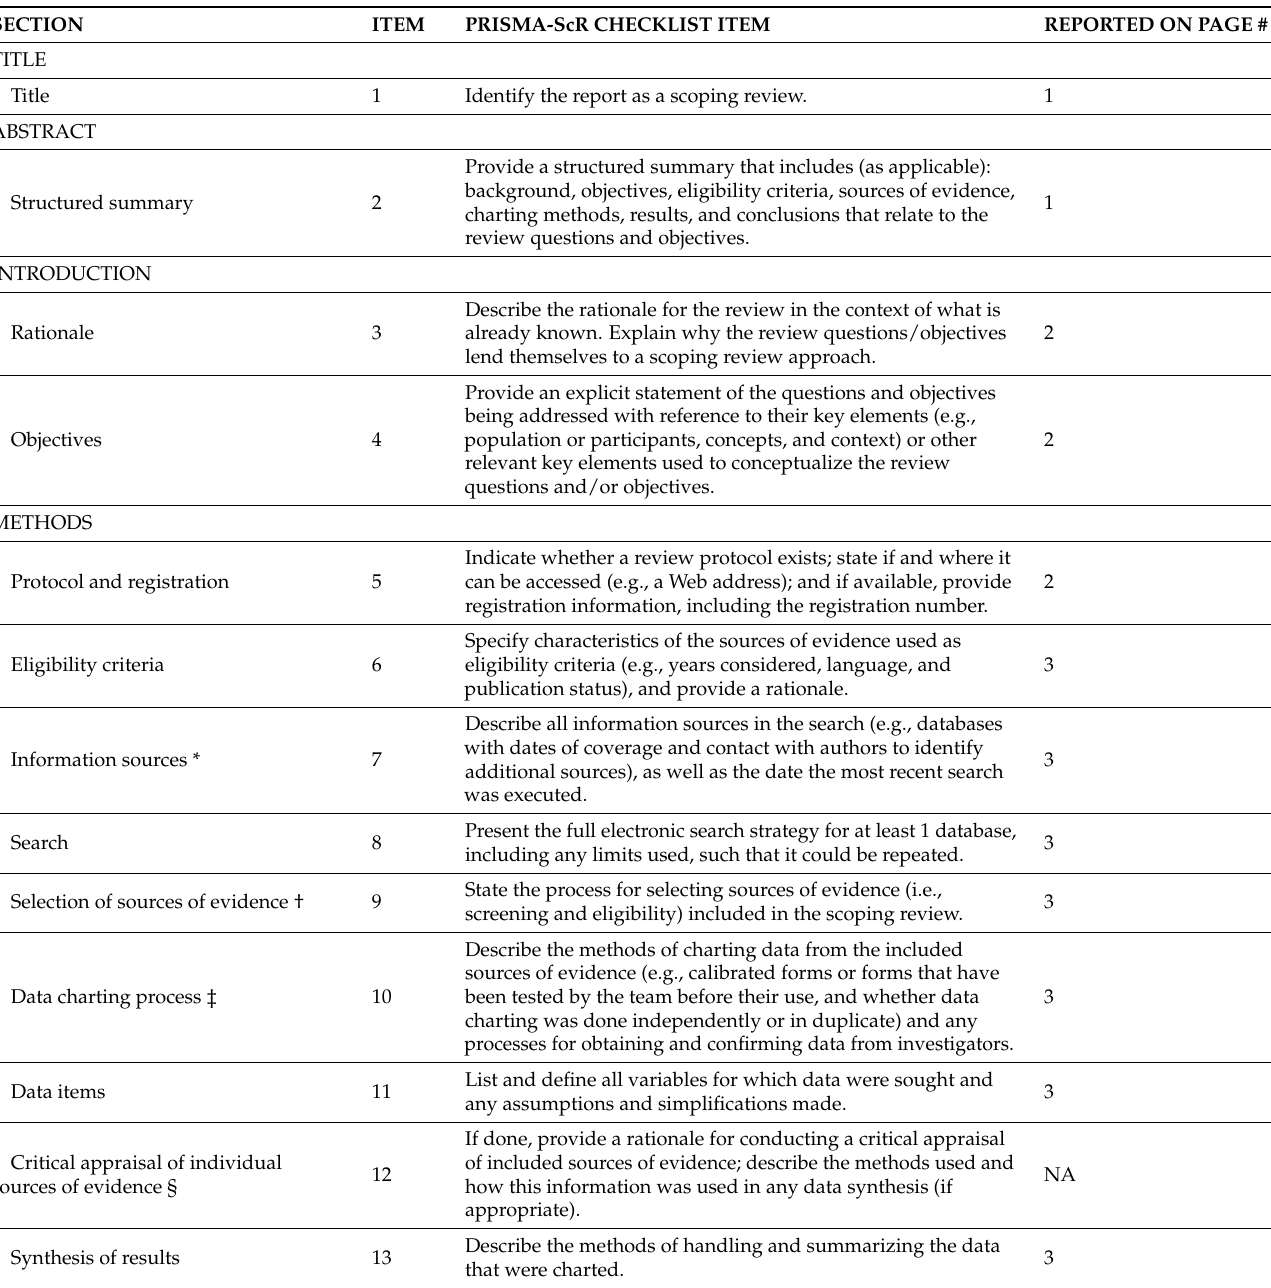
Table A1. Preferred Reporting Items for Systematic Reviews and Meta-Analyses extension for Scoping Reviews. (PRISMA- ScR)